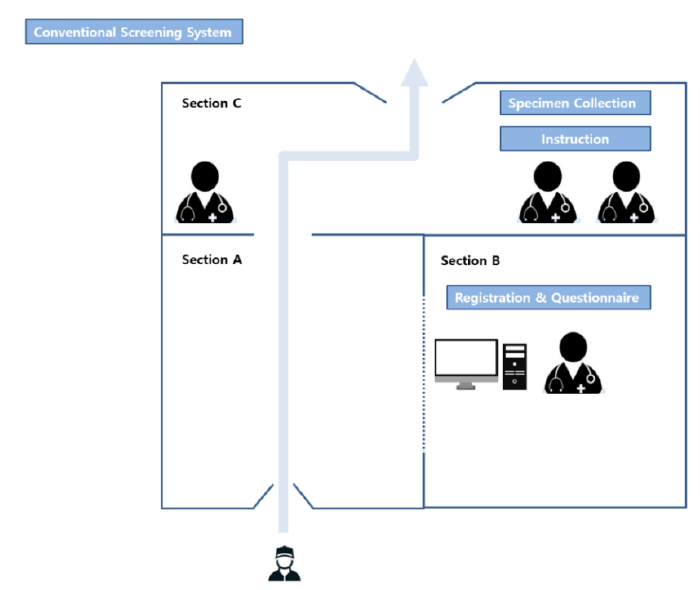
Figure 1. Illustration of the conventional severe acute respiratory syndrome coronavirus 2 (SARS-CoV-2) screening process.